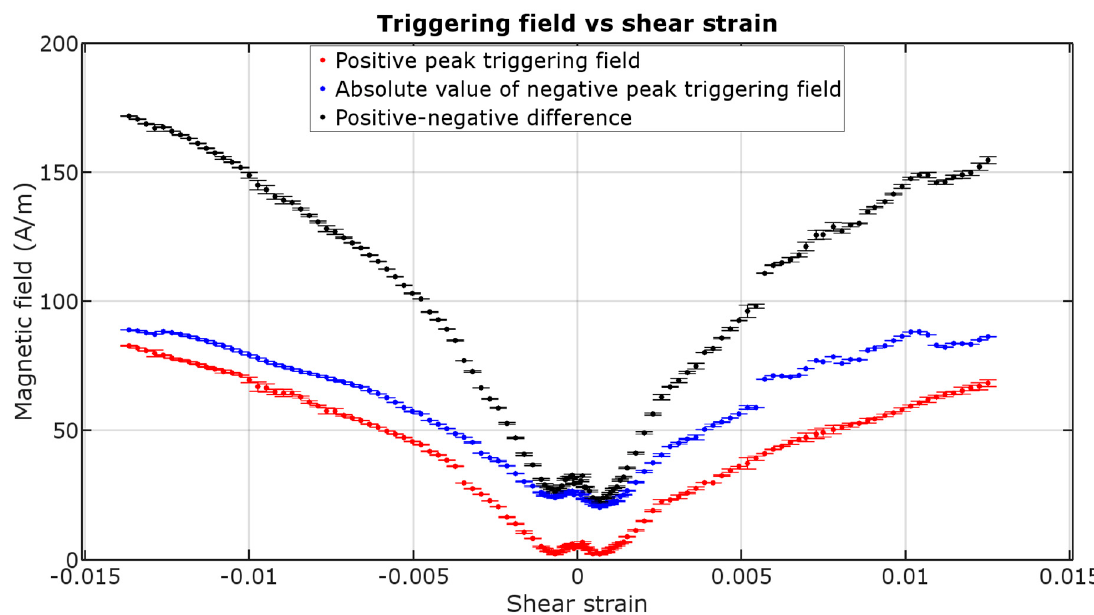
Figure 5. Triggering field of positive peak, negative peak and their difference caused by shear strain (±1 std. deviation).